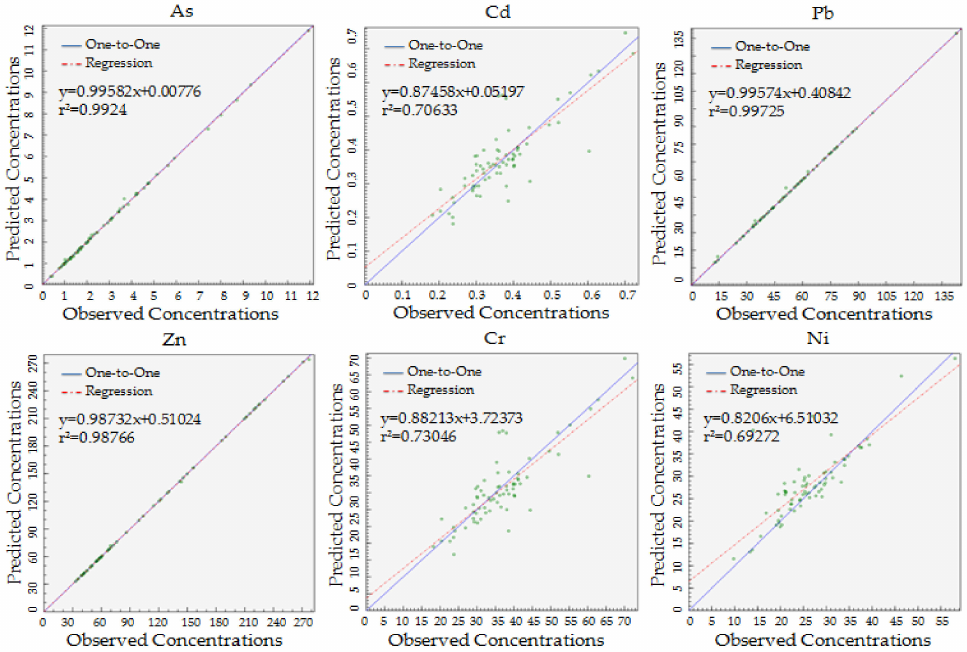
Figure 4. Fitting between elements observed concentrations and predicted concentrations by